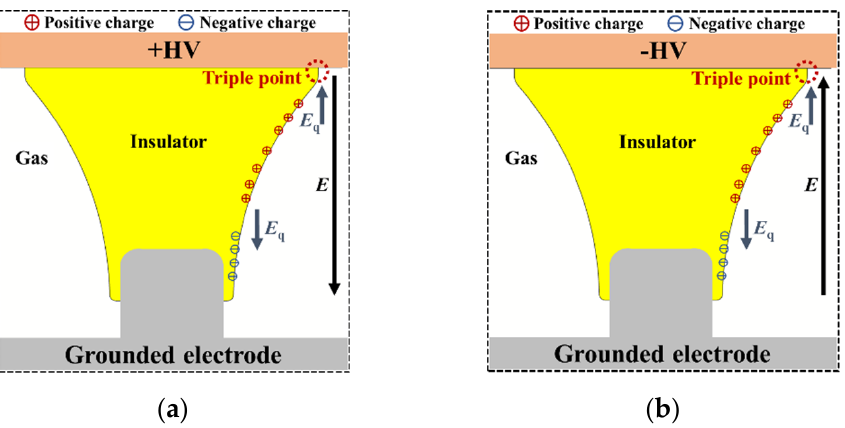
Figure 10. Effect of surface charge accumulation on surface flashover of tri–post epoxy insulator. ( a ) Positive DC + Positive LI; ( b ) Positive DC + Negative LI.